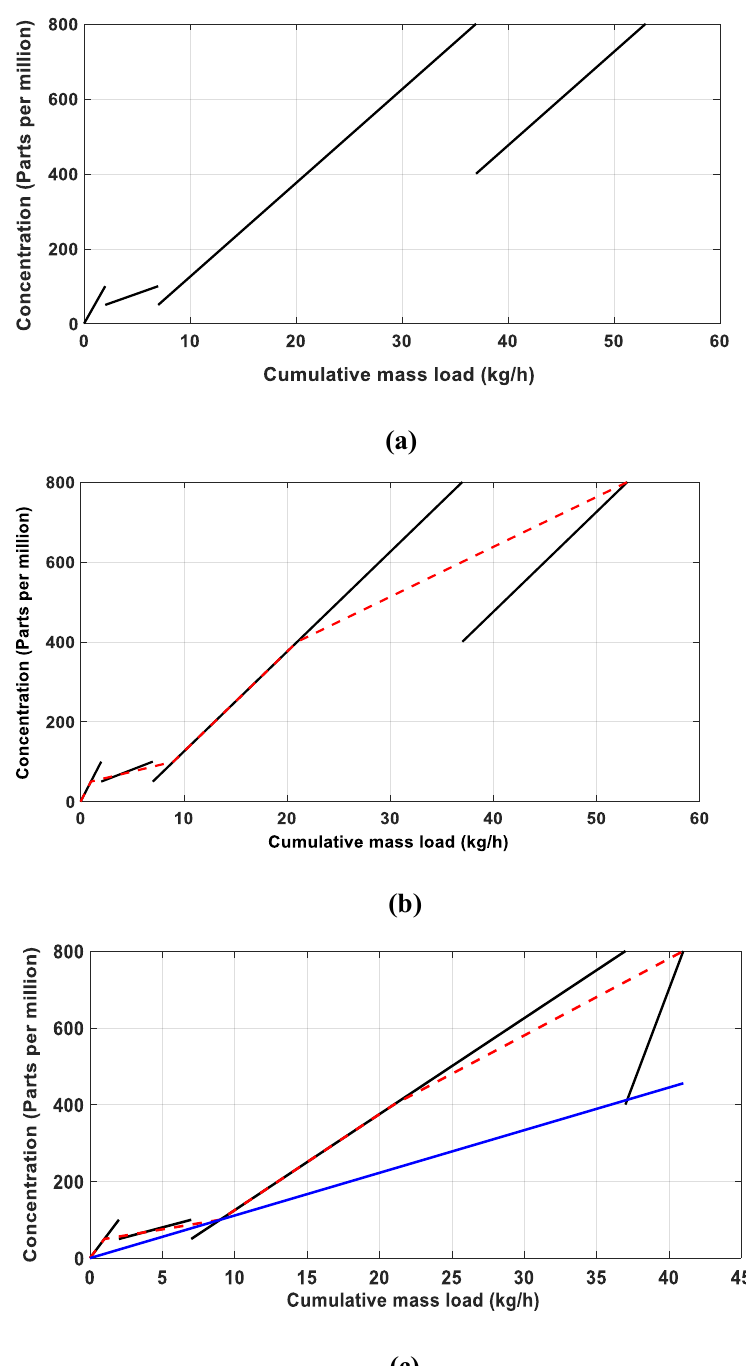
Figure 1 . Step by step diagram of restriction curve and water supply line with Wang and smith’s data 2) Raw water supply line without water reuse is drawn by connecting the origin of coordinate system to maximum output concentration. This line can be located higher than the combined concentration curve. However, raw water supply line should be placed lower than the combined concentration curve due to effective forces and pollutant mass exchange. Therefore, water